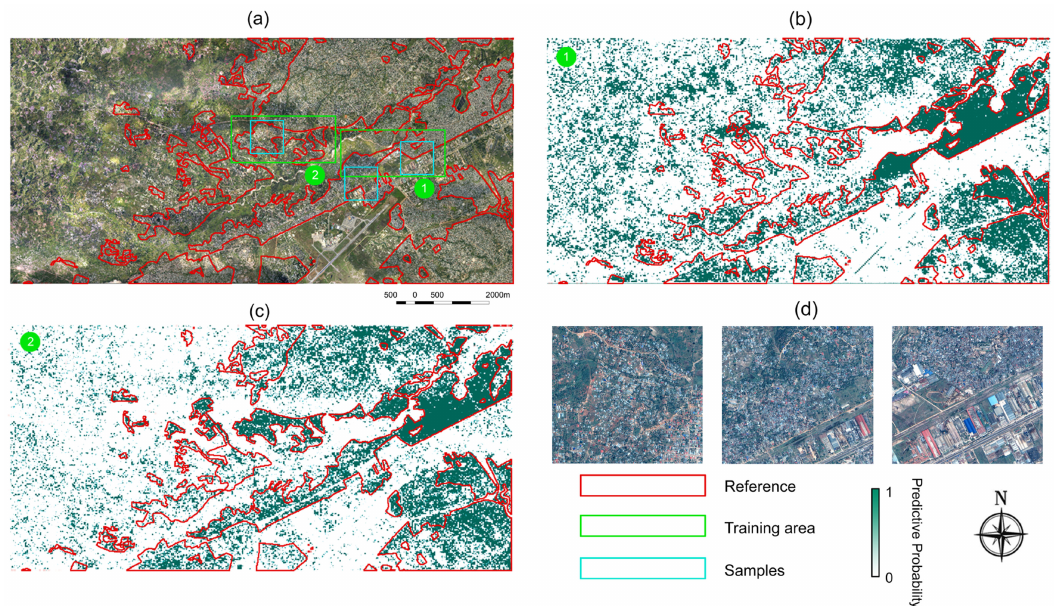
Figure 6. Deprived area mapping in Dar es Salaam, Tanzania: ( a ) reference data of deprived areas showing the center and its adjacent western suburban areas; ( b ) deprived area mapping using training area 1 labelled in ( a ); ( c ) deprived area mapping using training area 2 labelled in ( a ); and ( d ) gradient of deprived area configurations from suburban to urban areas labelled in ( a ) by blue boxes from left to right (Image source: Pleiades image provided via the ESA Third Party data